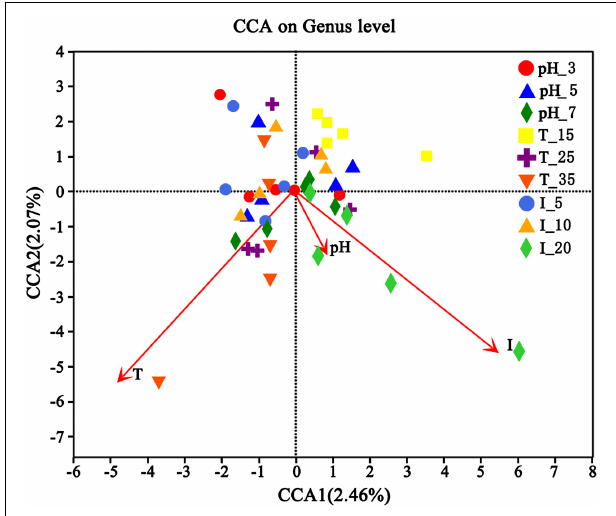
FIGURE 11 | Canonical correlation analysis (CCA) of uranium tailings after stabilization for 15 days under different environmental